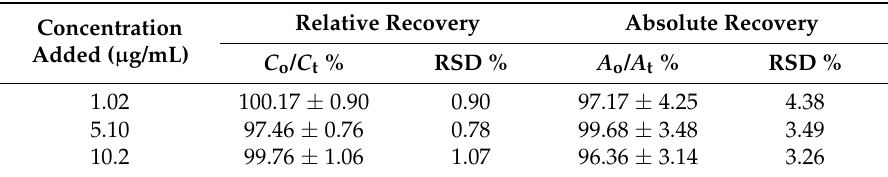
Table 5. Extraction recovery of Oxy-Di-OA in rat plasma (mean ± SD, n = 5). Relative Recovery Absolute Recovery Concentration Added ( µ g/mL) C o / C t % RSD % A o / A t % RSD